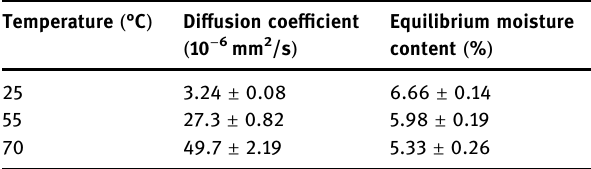
Table 1: Di ff usion coe ffi cient and the equilibrium moisture content at di ff erent